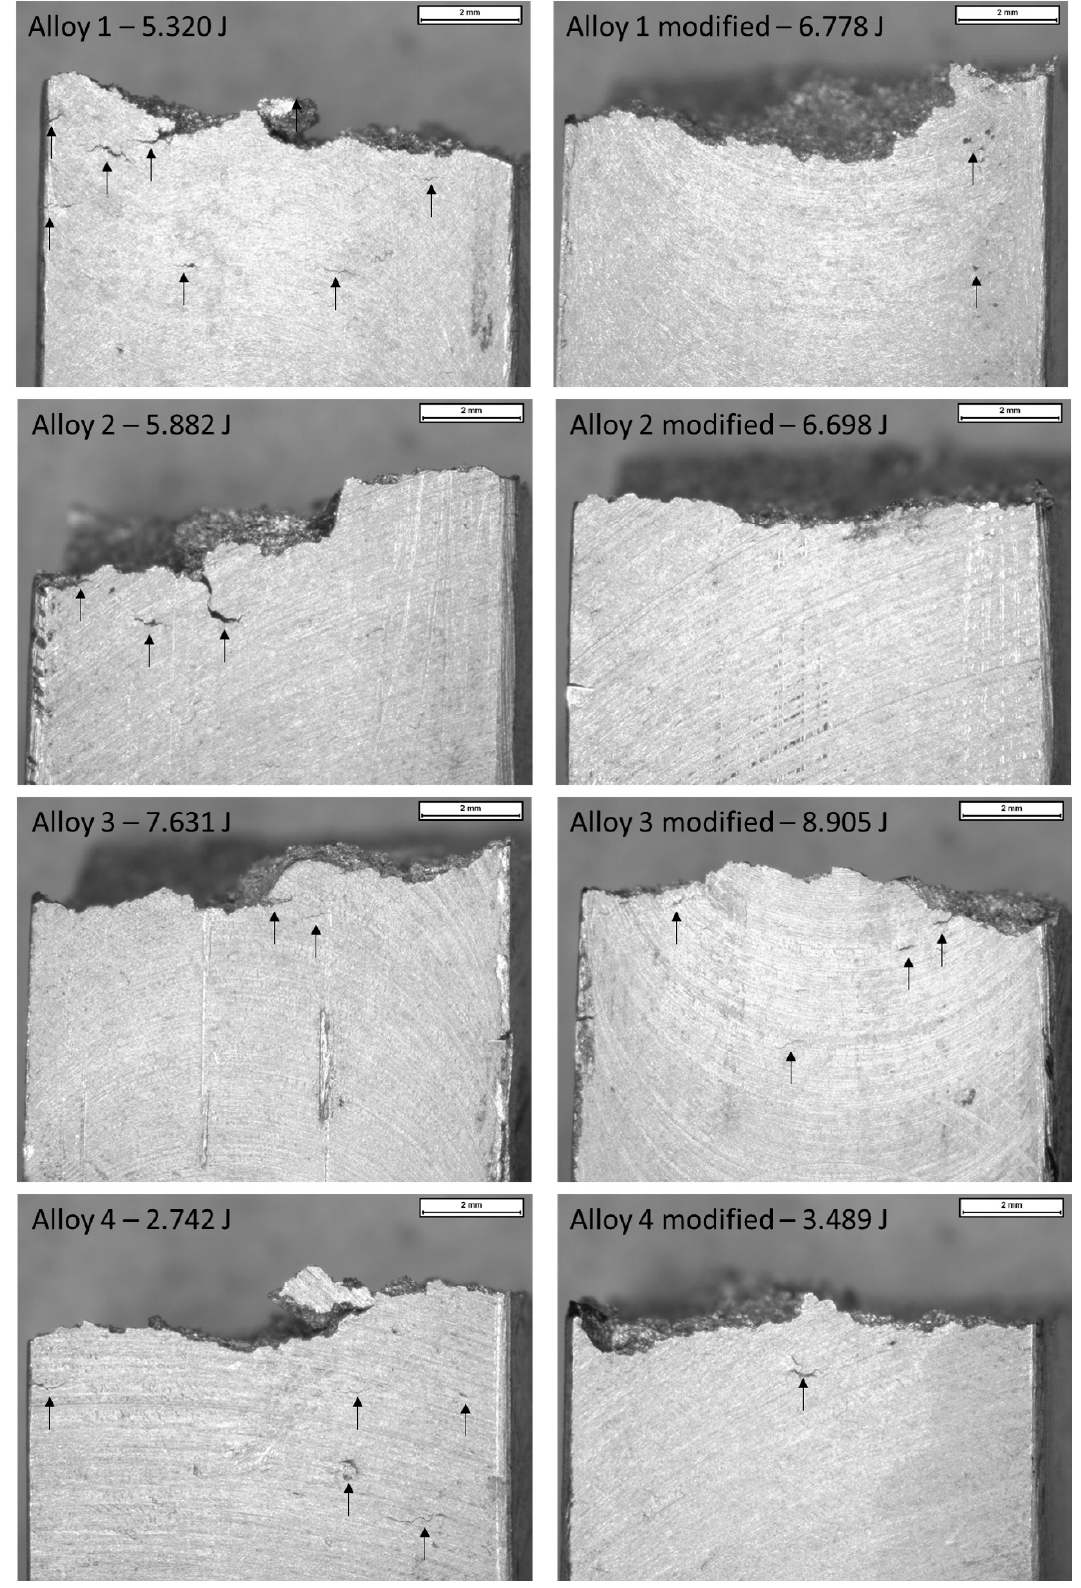
Figure 12. Macrographic images of fracture surfaces in impact specimens (0.63×). Arrows indicate the cracks documented in specimens after impact tests. Impact energies reported are the minimum measured in the unmodified samples and the maximum measured in the modified samples.